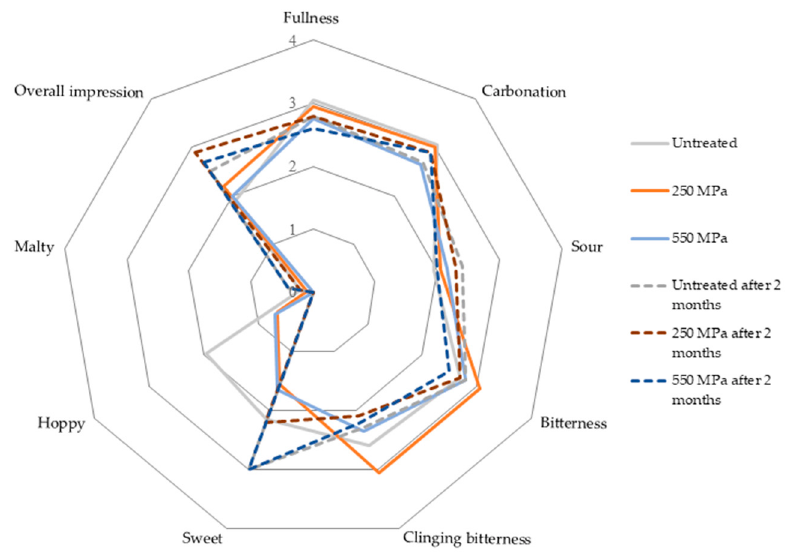
Figure 3. A radar plot of sensory parameters obtained from the descriptive analysis of beers right after